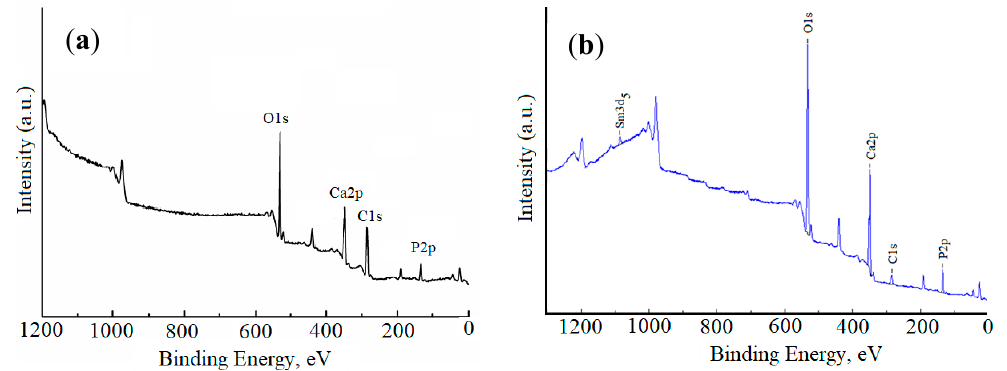
Figure 7. X-ray photoelectron spectroscopy (XPS) general spectrum of the coating with ( a ) x Sm = 0 (HAp) and ( b ) x Sm = 0.05 (5SmHAp) .